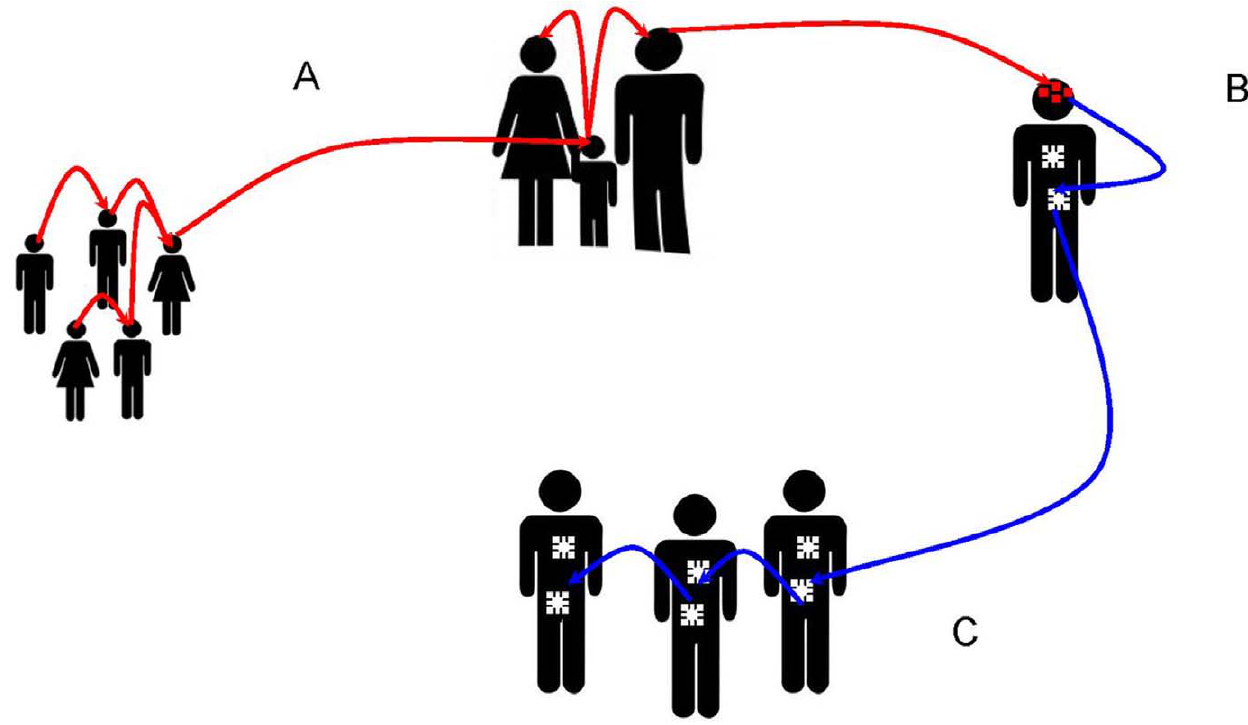
Figure 6. Proposed scenario for the evolution of head and body lice. (A) Head lice propagate among humans; (B) in heavily infested patients, head lice might lay eggs in clothes, and resulting lice might develop and subsequently spread among humans as body lice.